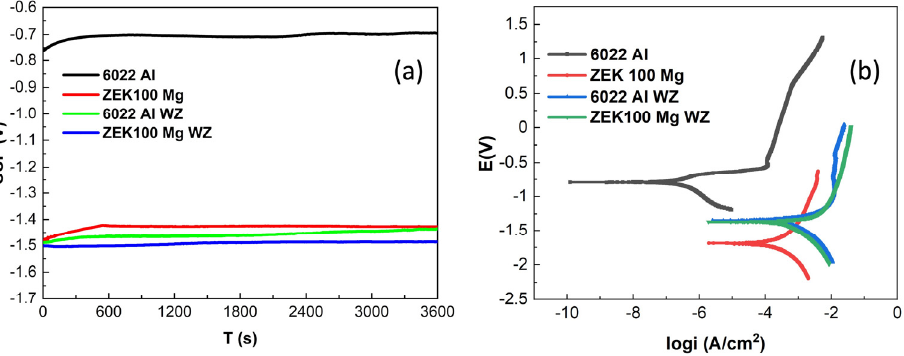
Figure 10. ( a ) OCP plots (vs. Ag/AgCl) for 6022 Al and ZEK100 Mg and their weld zone (WZ), respectively; ( b ) potentiodynamic plots on 6022 Al ZEK100 Mg and their welding zone, respectively.